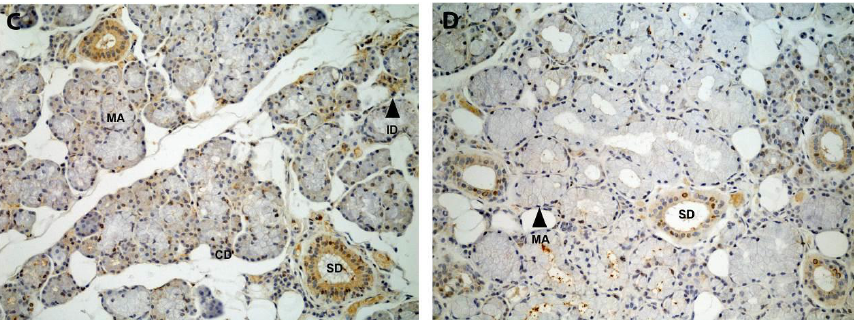
Figure 3. Immunohistological expression of nerve growth factor (NGF) in salivary glands. ( A ) parotis. ( B ) submandibular gland; ( C ) sublingual gland; ( D ) labial glands. CD, collecting duct; ID, intercalated duct; MA, mucous acinus; SA, serous acinus; SD, striated duct. The brown color indicates positive staining. Counterstaining with hematoxylin (blue). Original magnification, 20 ×. With permission from ref. [7]. Int. J. Mol. Sci. 2017 , 18 , 386